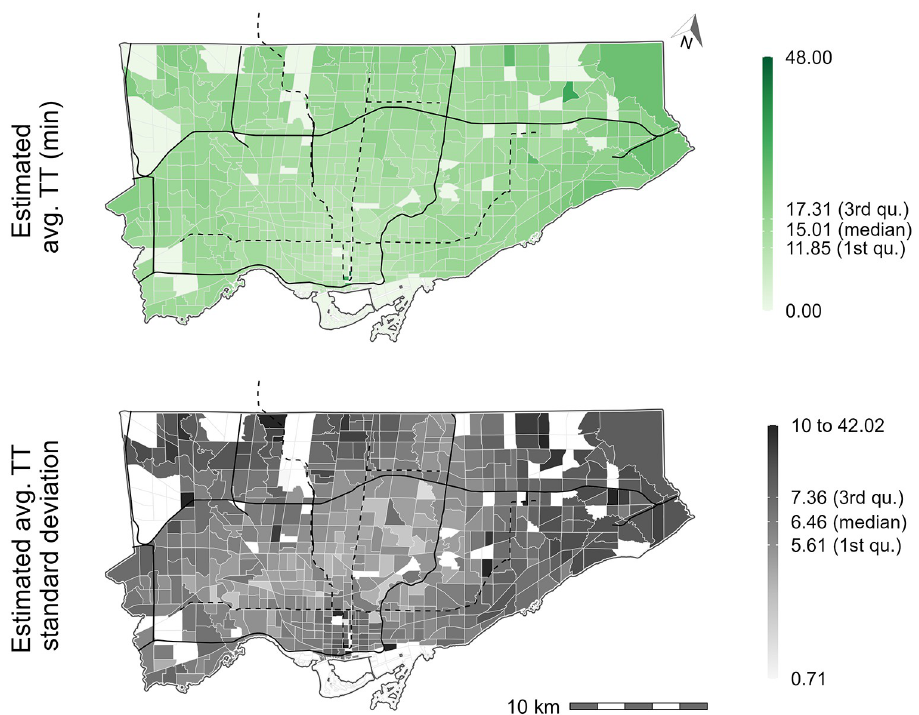
Fig 5. Mean car travel time to jobs per origin (top) and standard deviation of car travel times per origin (bottom) for the city of Toronto. Origin destination flows are provided by the 2016 TTS and car travel times estimated using r5r. Black lines represent expressways and black dashed lines represent subway lines. White TAZ represent a TAZ with no workers hence no travel time.